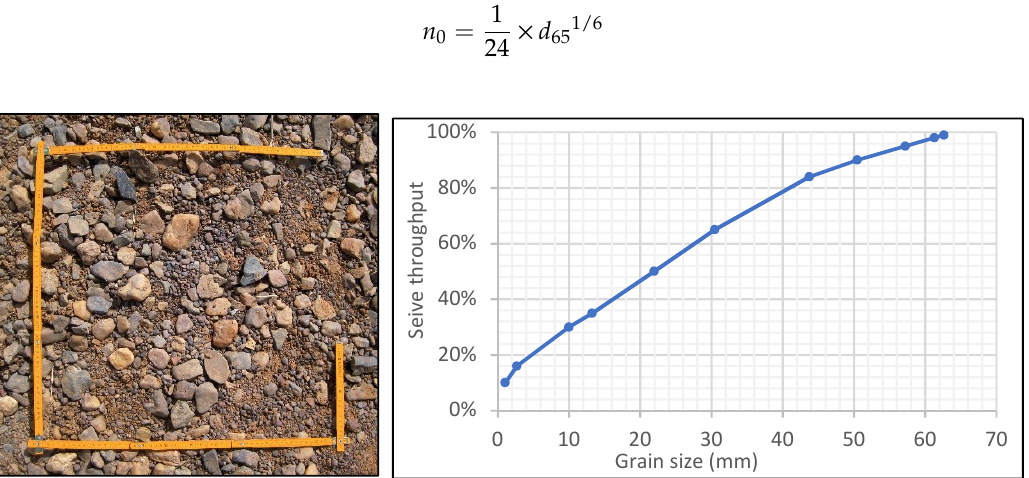
Figure 8. Representative grain size distribution of sediments along the Sirba River.